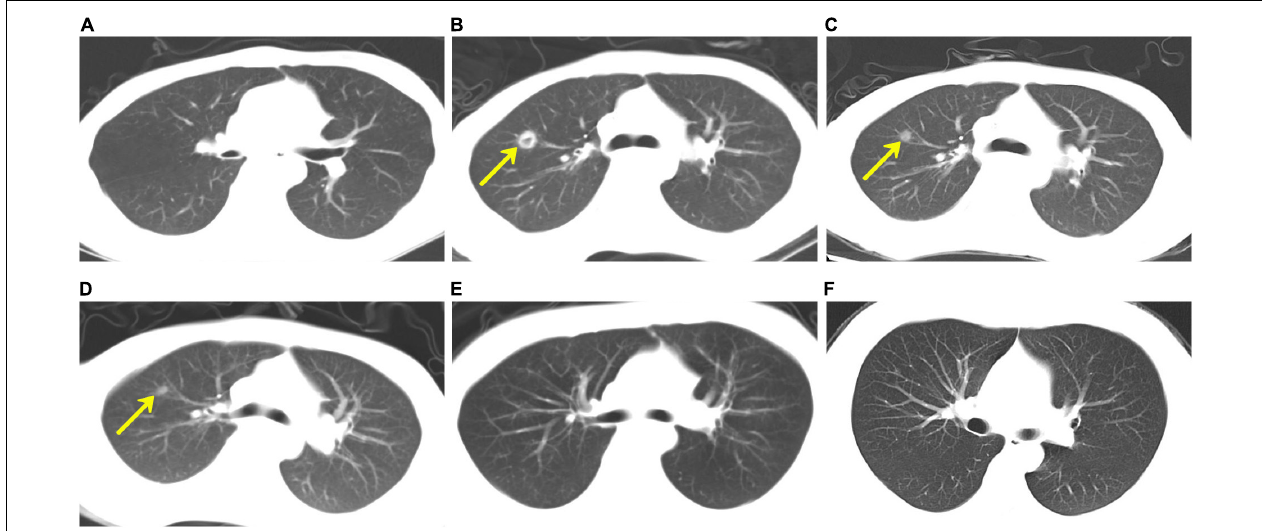
FIGURE 1 | Computed tomography (CT) scan of the chest. (A) As part of his evaluation after haematopoietic stem cell transplantation, chest CT was unremarkable on day + 92. (B) On day + 123, the patient developed a fever and anorexia, and chest CT revealed a new right upper lobe defined nodule (17 × 15 mm) surrounded by a ring of consolidation. Chest CT scans, which were performed on days + 152 (C) , + 251 (D) , and + 519 (E) , respectively, demonstrated a gradual reduction of nodule size. (F) On day + 540, the chest CT revealed that the original right upper lobe nodule disappeared completely.